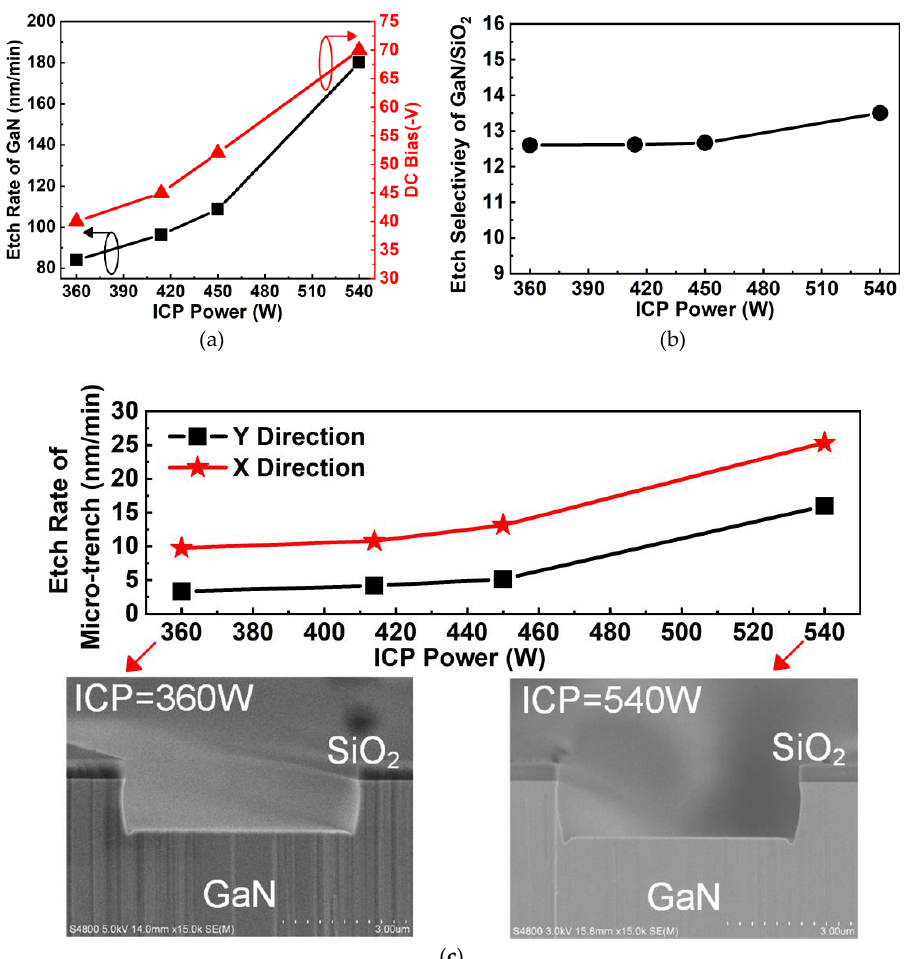
Figure 9. ( a ) Etching rate of GaN and DC bias as a function of ICP power. ( b ) Etching selectivity of GaN over SiO 2 as a function of ICP power. ( c ) The effect of ICP power on the etching rates of the microtrench in the X and Y directions. The insets of (c) show cross SEM images for samples etched with 360 W and 540 W ICP power.